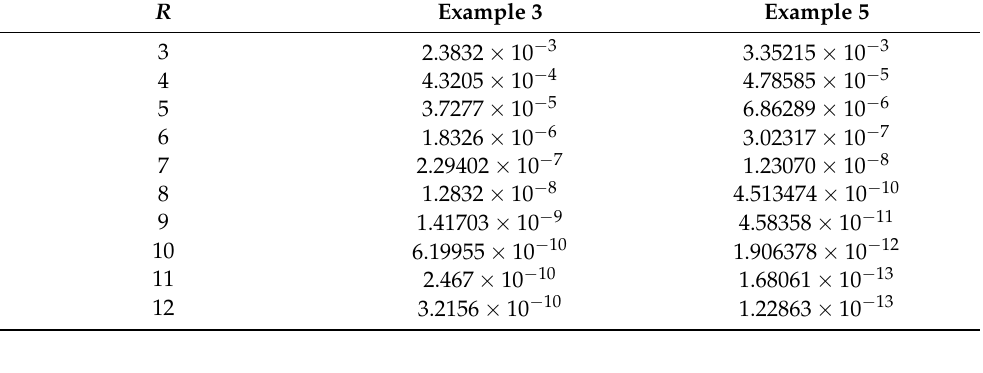
Table 4. MAEs of Examples 5 and 3 for different values of R .